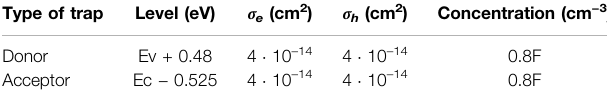
TABLE 2 | Details of the two-level bulk damage model F is the fl uence in n eq /cm 2 . Type of trap